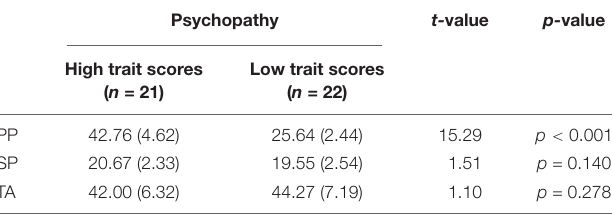
TABLE 1 | Means and standard deviations of LSRP and STAI scores by